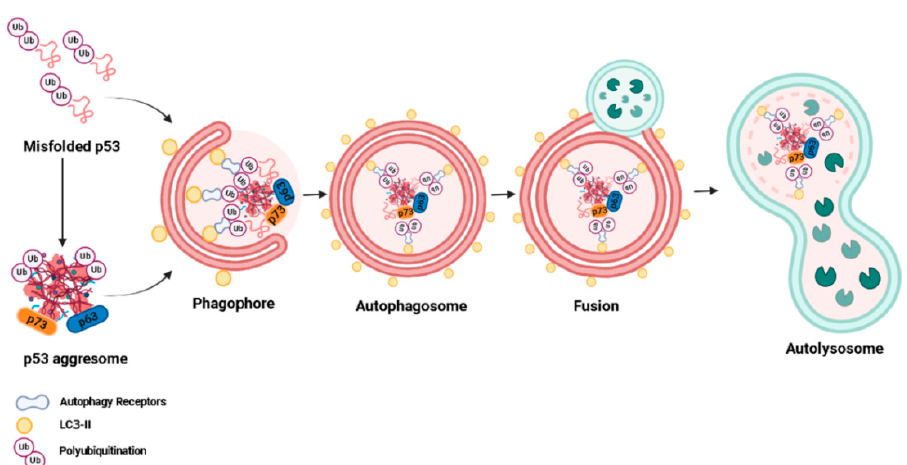
Figure 2. Aggrephagy mechanism described in p53-expressing cancer cells. Misfolded p53 and its aggresomes are recognized by autophagy receptors, such as p62, and are then directed to autophagic degradation. The autophagy process involves the formation and elongation of the phagophore membrane; engulfment of protein aggregates by the phagophore membrane to form autophagosomes; fusion of the autophagosome with lysosomes to form autophagolysosomes; and degradation of protein aggregates by proteolytic enzymes in lysosomes.